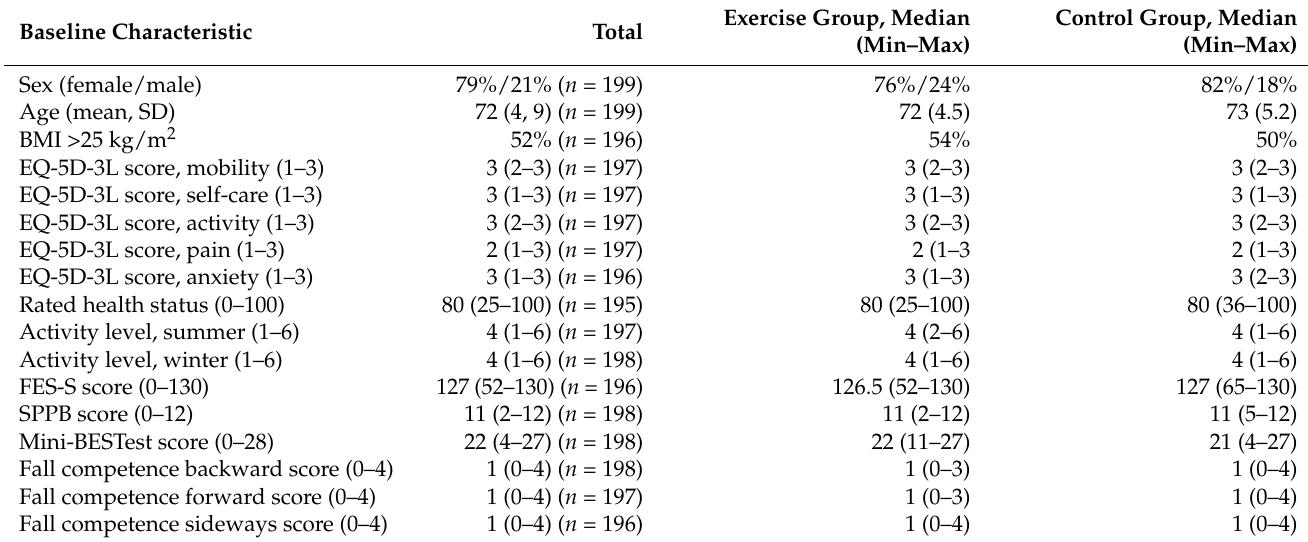
Table 1. Baseline characteristics for all participants at baseline ( n =